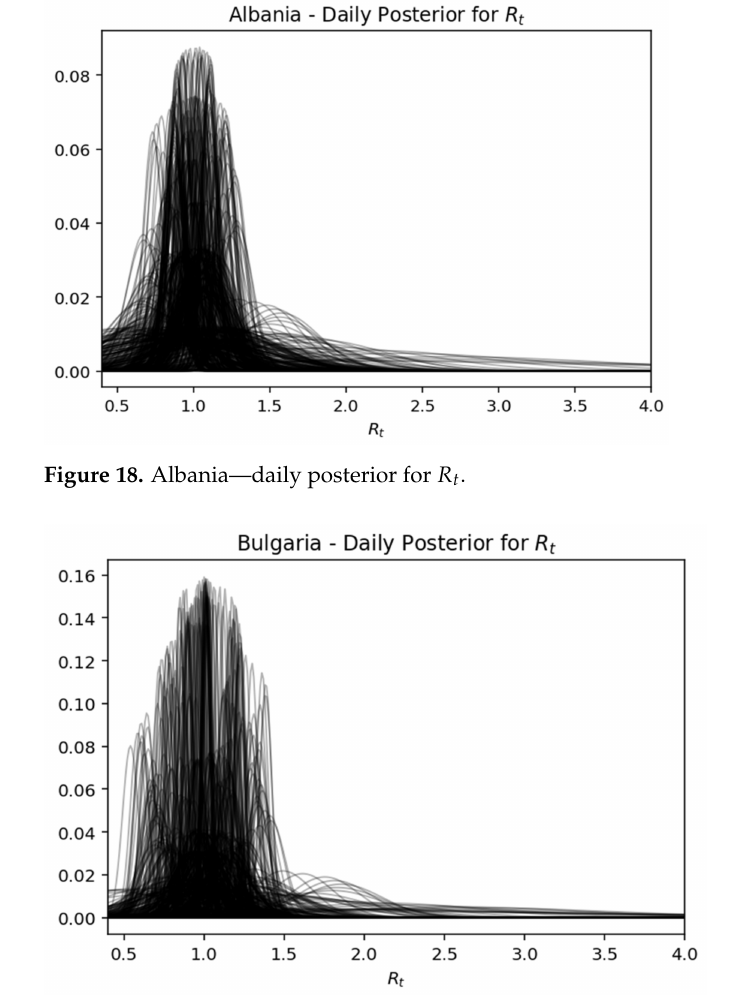
Figure 19. Bulgaria—daily posterior for R t .